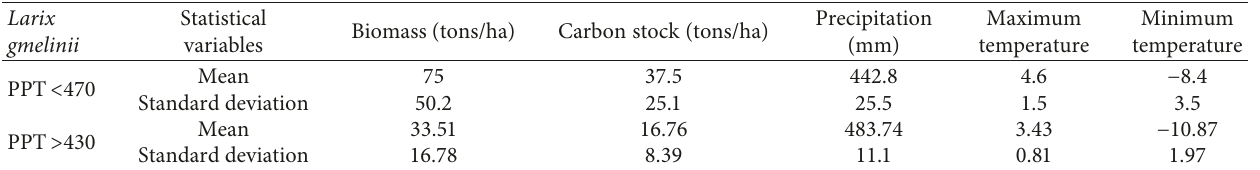
Table 1: Mean and standard deviation of stem biomass, carbon stock, precipitation, and temperature variables on precipitation > 470mm and < 470mm of Larix gmelinii across the geographic regions of Daxing’anling Mountain of Inner Mongolia,